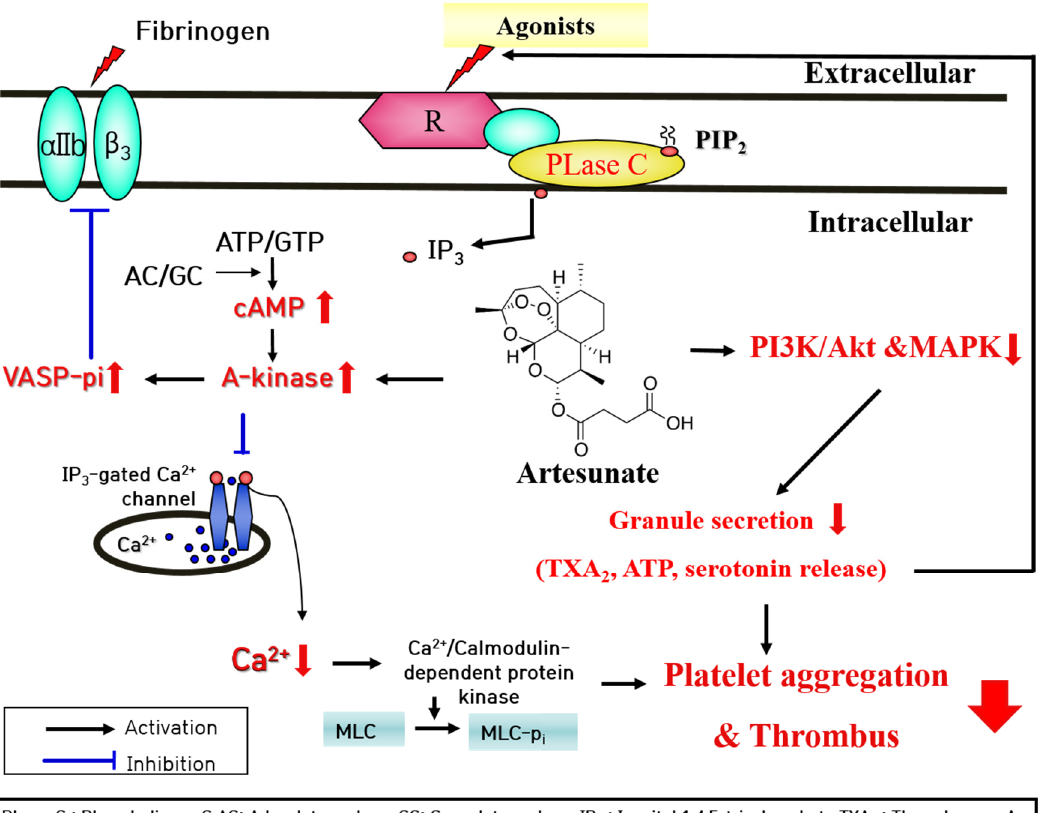
Figure 9. A schematic summary of inhibitory effects of artesunate on the platelet intracellular signaling pathway.